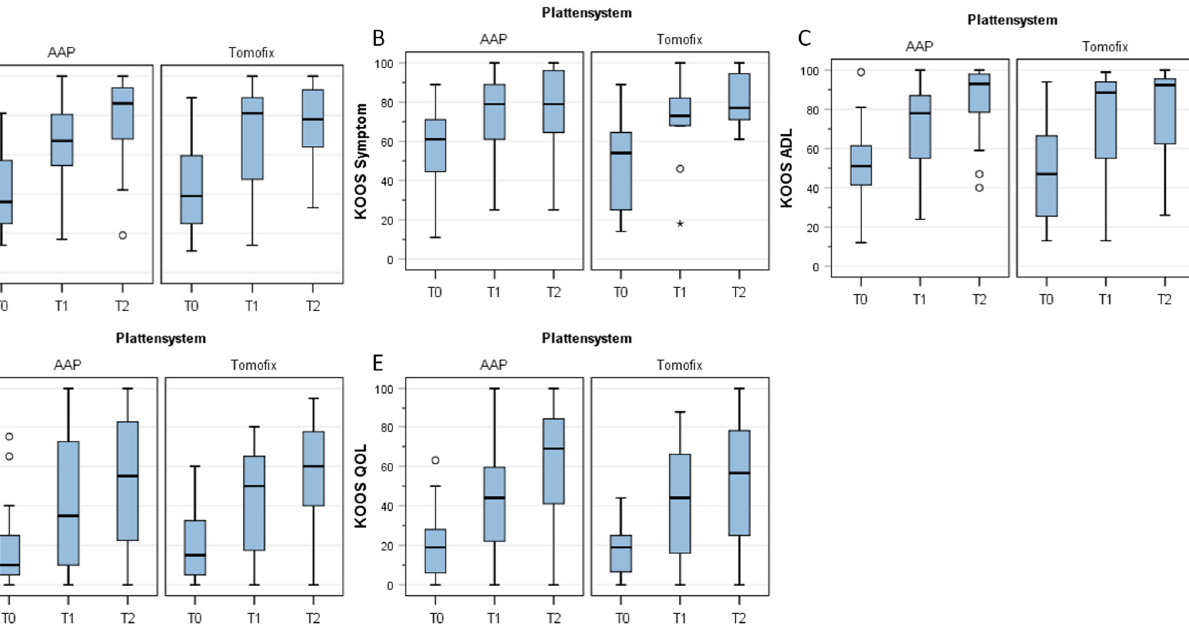
Figure 3. KOOS subscores, ( A ) pain, ( B ) symptoms, ( C ) function, ( D ) sports and recreational activities, and ( E ) quality of life. No differences were observed between the two cohorts.